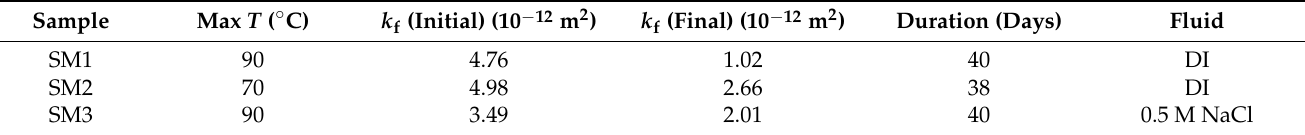
Figure 5. Time-dependent fracture permeability evolution with intermittent flow at 90 °C (SM1 and SM3) and 70 °C (SM2). Each symbol represents a steady-state permeability measurement. The open symbols indicate permeability measured at room temperature at the beginning and end of the experiments, respectively. Table 3. Summary of experimental results.